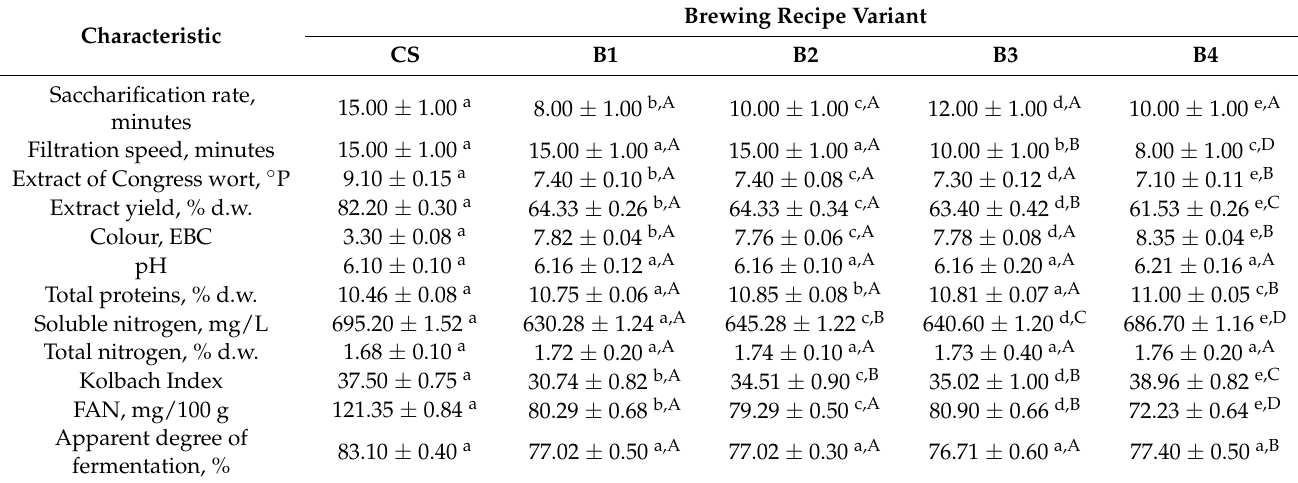
Table 6. Physico-chemical properties of wort for the second